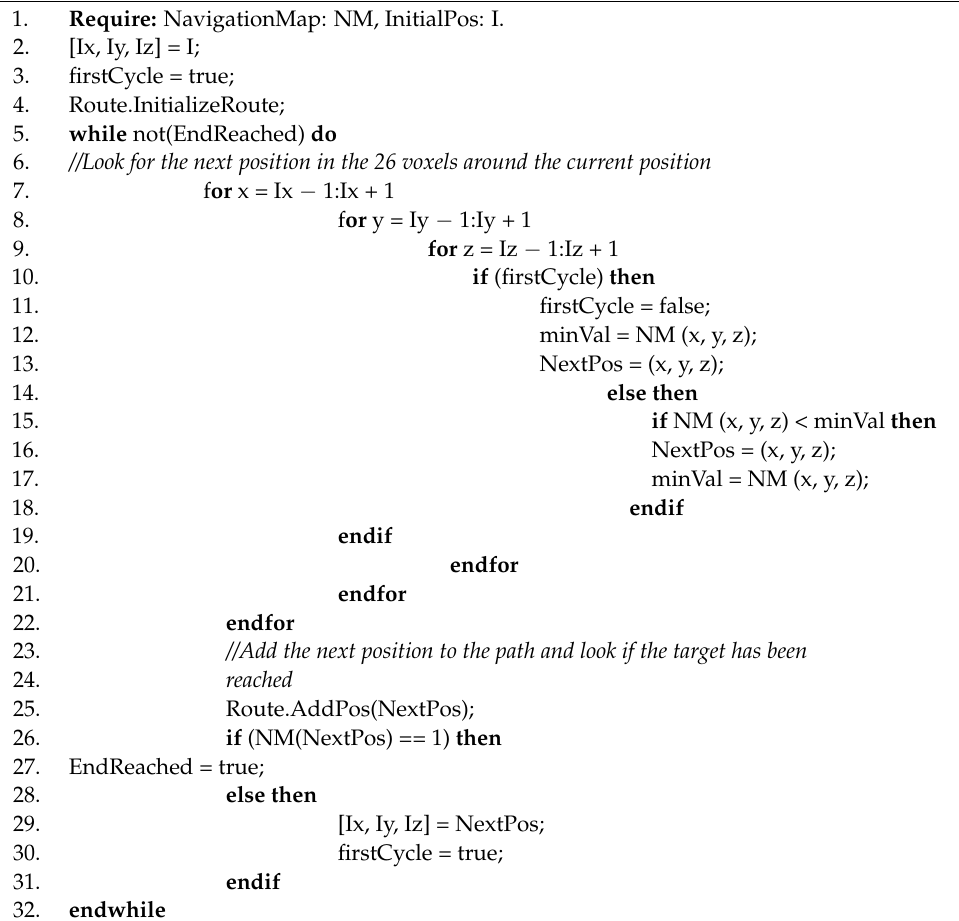
Algorithm 2 Path Planning